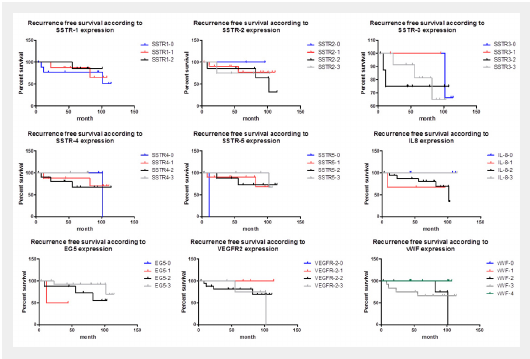
Kaplan-Meier curve showing the different markers and recurrence- free survival. Eg5 = kinesin spindle protein; IL-8 = interleukin-8; SSTR = somatostatin receptor; VEGFR-2 = vascular endothelial growth factor receptor-2; vWF = von